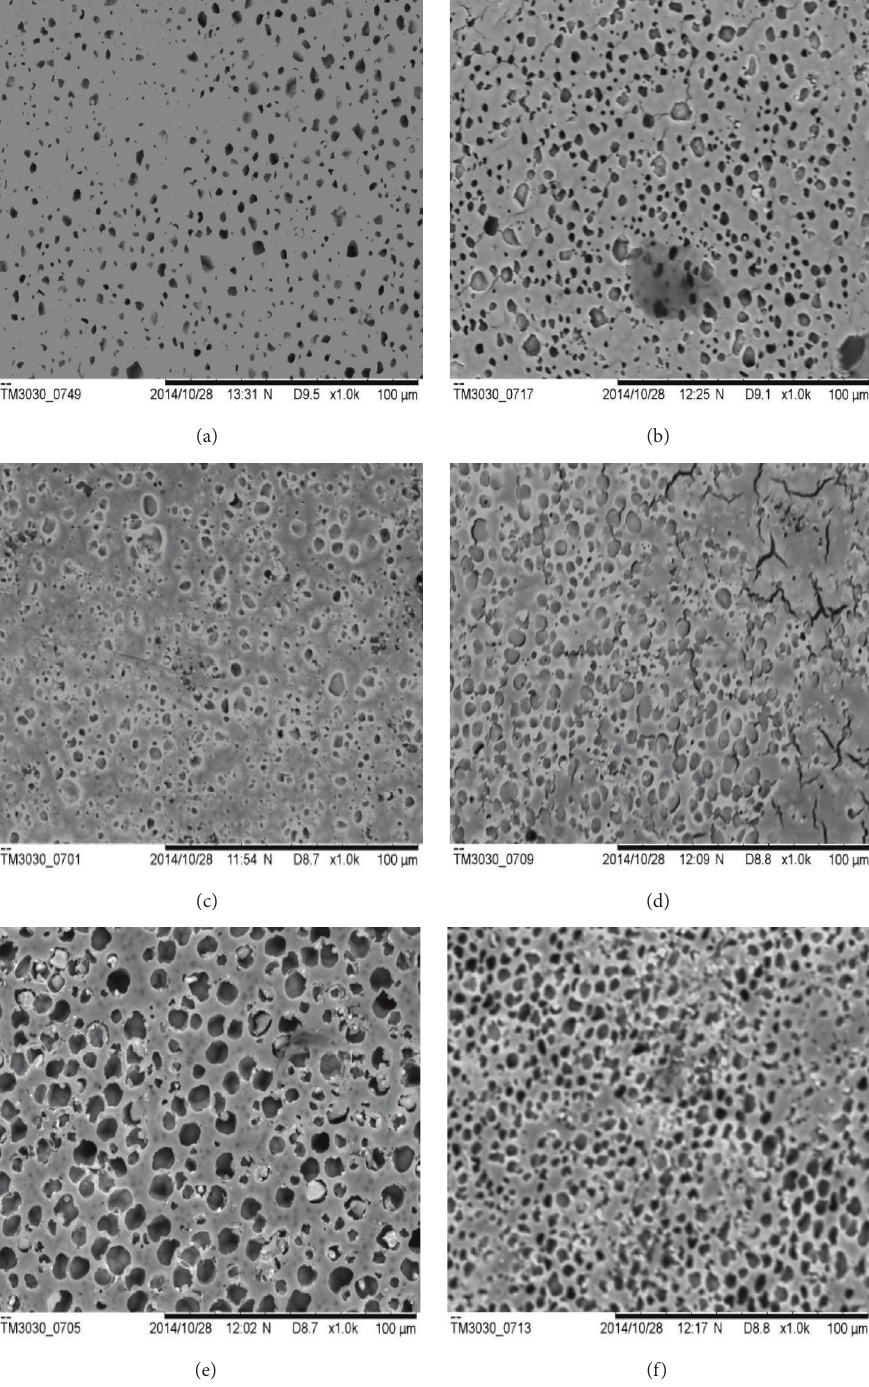
Figure 3: SEM micrographs of (a) pure PLA, (b) PLA/FS, (c) 2 wt% of PLA/FS/clay (1.28E) nanocomposite, (d) 5 wt% of PLA/FS/clay